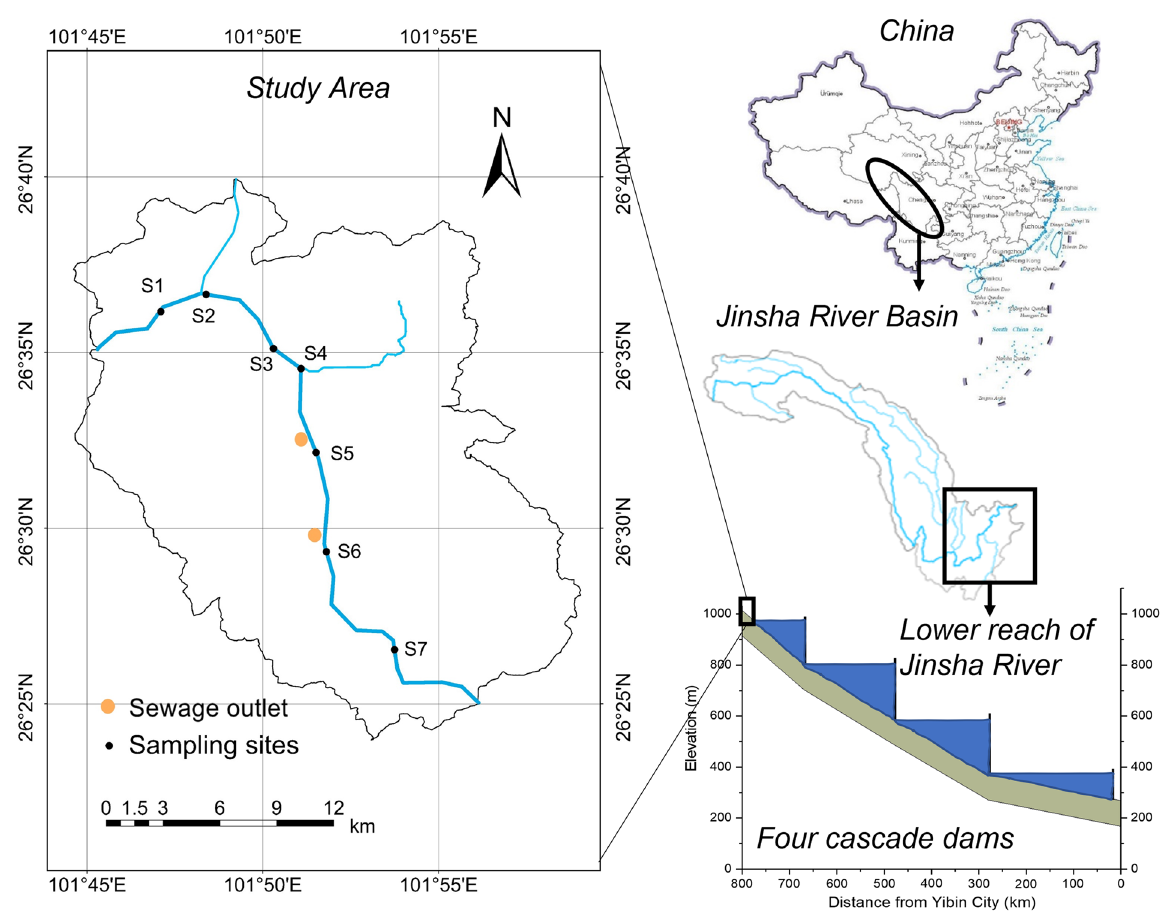
Figure 1. Location of the study area and distribution of sampling sites. The map of Jinsha River Basin and study area were generated using the ArcGIS Desktop (ESRI, Inc, Version 10.7, URL:https:// deskt op. arcgis. com/ zh- cn/). The map of China was downloaded from Standard Map Services, which is an free access map database provided by the Ministry of Natural Resources of the People’ Republic of China (URL: http:// bzdt. ch. mnr. gov. cn/ browse. html? picId=% 224o2 8b062 5501a d1301 5501a d2bfc 0290% 22, reference number: